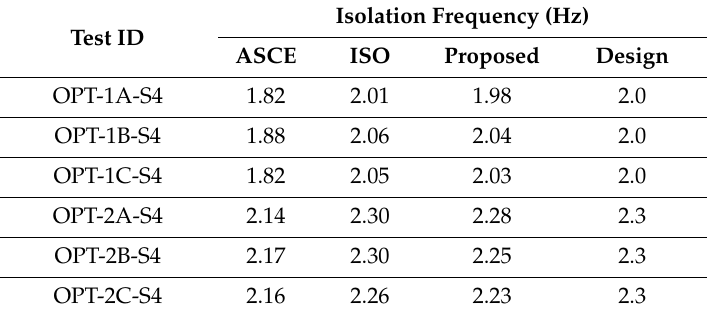
Figure 17. Determined equivalent viscous damping ratio: ( a ) OPT-1; ( b ) OPT-2.